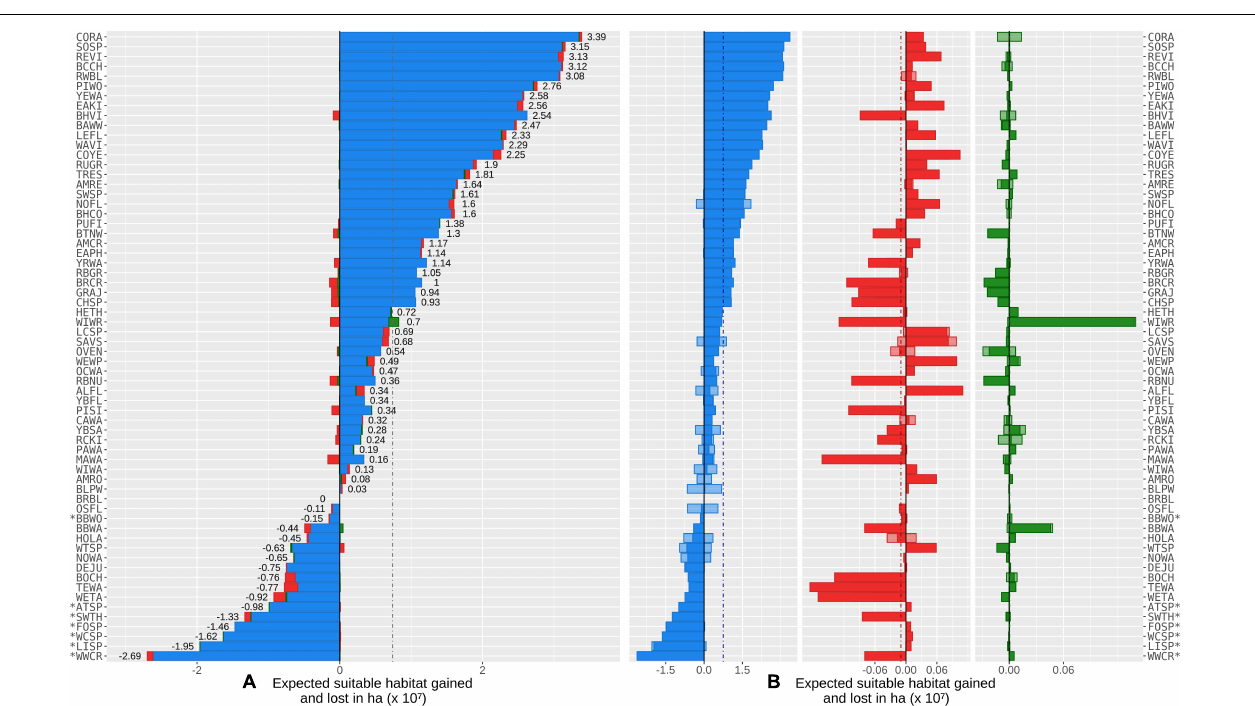
FIGURE 6 | Direct and indirect effects of climate change on the distributions of 64 landbird species within the study area ( Supplementary Appendix I Figure A1 ). Effects are measured as the absolute or relative differences between paired climate-sensitive and non-climate sensitive models ( Table 1 ) in the changes in pixel occupancy between 2011 and 2100, in terms of probabilities calculated over replicates. Left to right, (A) the net direct effects (Scenarios [IV, VI, VII, VIII] – [I, II, III, V], Table 2 ); blue), and indirect effects via fire (Scenarios [II, V, VI, VIII] – [I, III, IV, VII], Table 2 ; red) and via forest change (Scenarios [III, V, VII, VIII] – [I, II, IV, VI], Table 2 ; green). Net effects are the difference between the climate sensitive model and non-climate sensitive model predictions, after calculating the total net area (gained minus lost); (B) light colored bars represent mean expected areas gained (positive) and lost (negative) for each one of the bird species due to direct (blue) and indirect effects of climate (red via fire, green via forest change). Full color bars depict the net effect (gained minus lost) of each of these pathways. The dotted lines represent the average across species. Species for which the net differences in abundance between paired climate-sensitive and non-climate sensitive models (i.e., losses higher than gains) were higher than 90% are marked with an